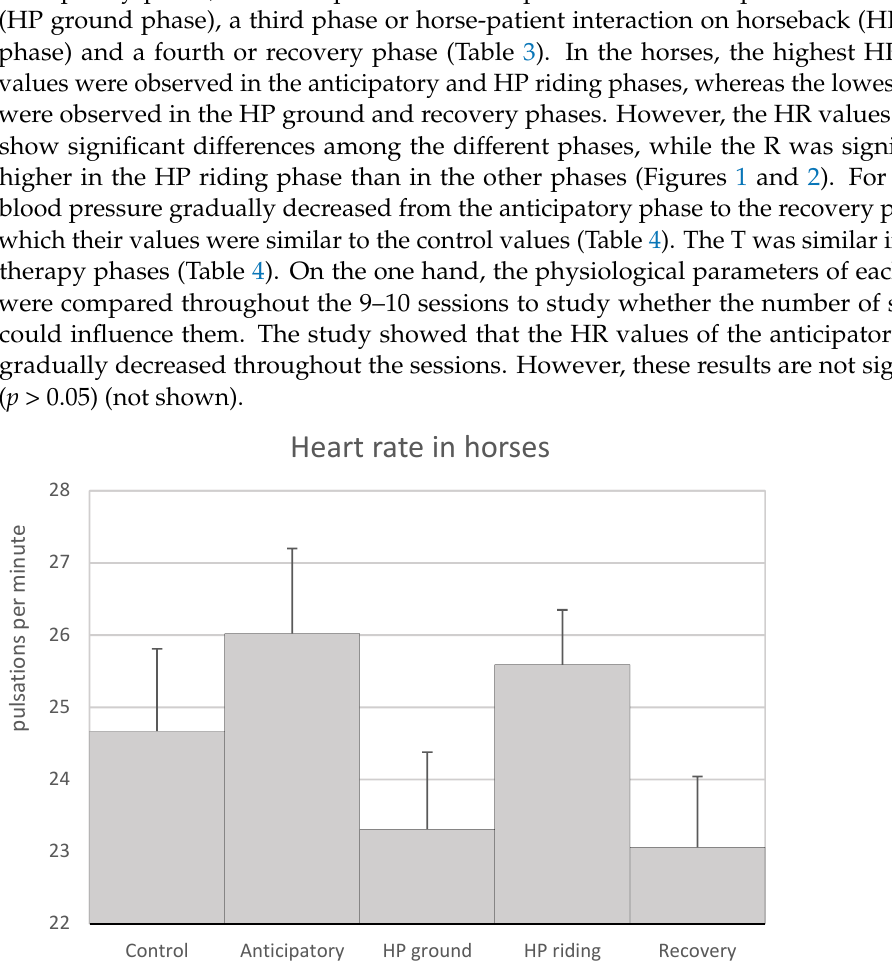
Figure 2. Mean values + SEM of the respiratory rate of the horses in the control and the anticipatory phases, the HP ground and HP riding phases (horse-patient interaction on the ground and on horse- back, respectively) and the recovery phase. The asterisk indicates that the values were significantly higher in the HP riding than in the HP ground and recovery phases ( p < 0.05).